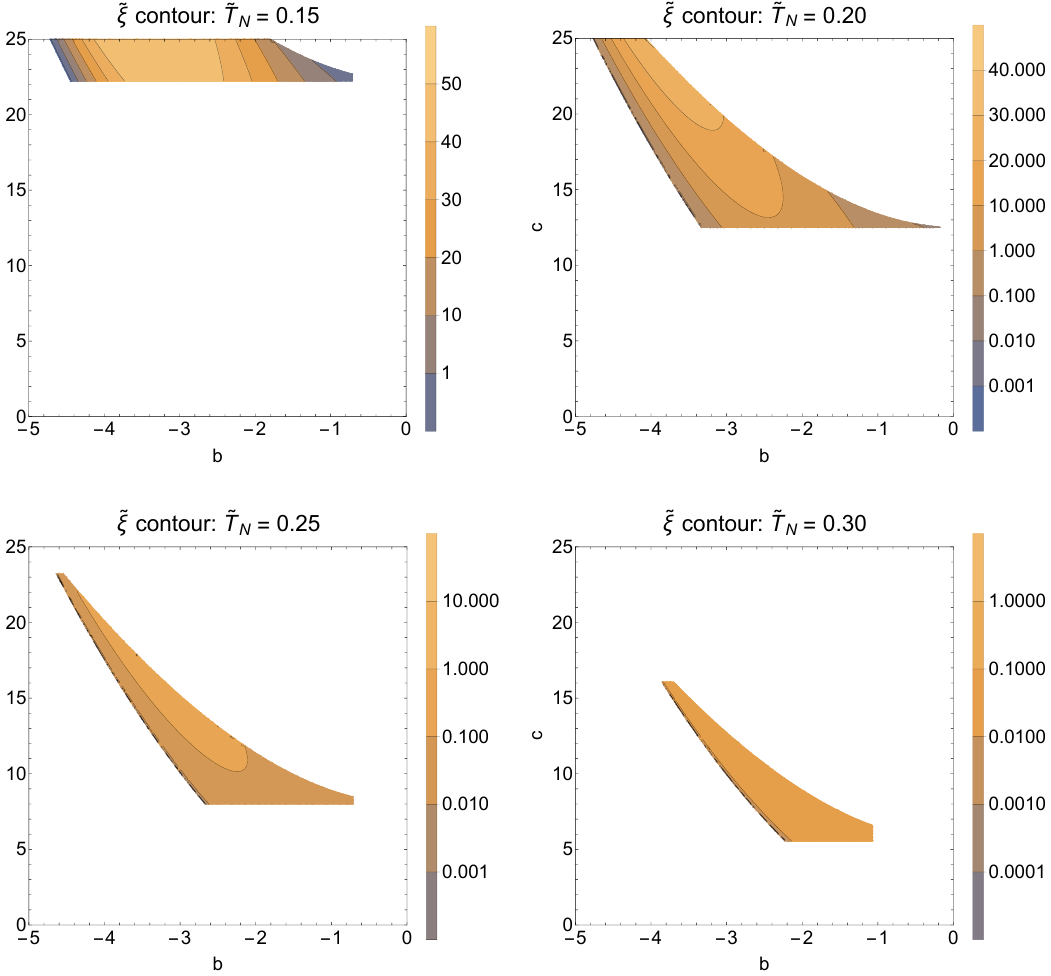
˜ Figure 5. Contours of ξ are shown in the ( b, c ) plane for the allowed parameter space for lower values of ˜ T : ˜ T = 0 . 15 (upper left), 0 . 20 (upper right), 0 . 25 (lower left), and 0 . 30 (lower right). N N The contours also satisfy the conditions: c ≥ b 2 , c ˜ T ˜ ˜ ˜ ˜ β/H ≥ S E / 140 T N and ξ ≥ 0